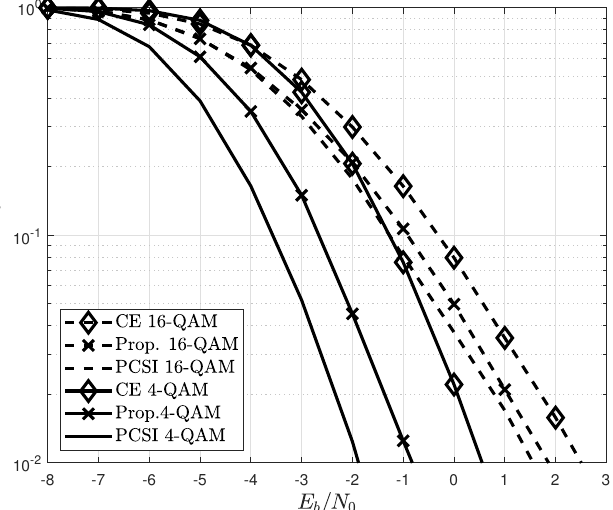
Figure 6. BLERs of conventional and proposed channel estimators for different modulations. The NMSEs of the proposed channel estimator for different data subblock lengths are shown in Figure 7. The NMSE improves as N b decreases. This is because the approximate MDP using data subblocks approaches the original MDP as N b decreases. However, as shown in Figure 7, the NMSE improvement is insignificant, whereas the complexity exponentially increases with T b . Thus, ( T b , N b ) = ( 16, 4 ) is considered in this study for the simulations.